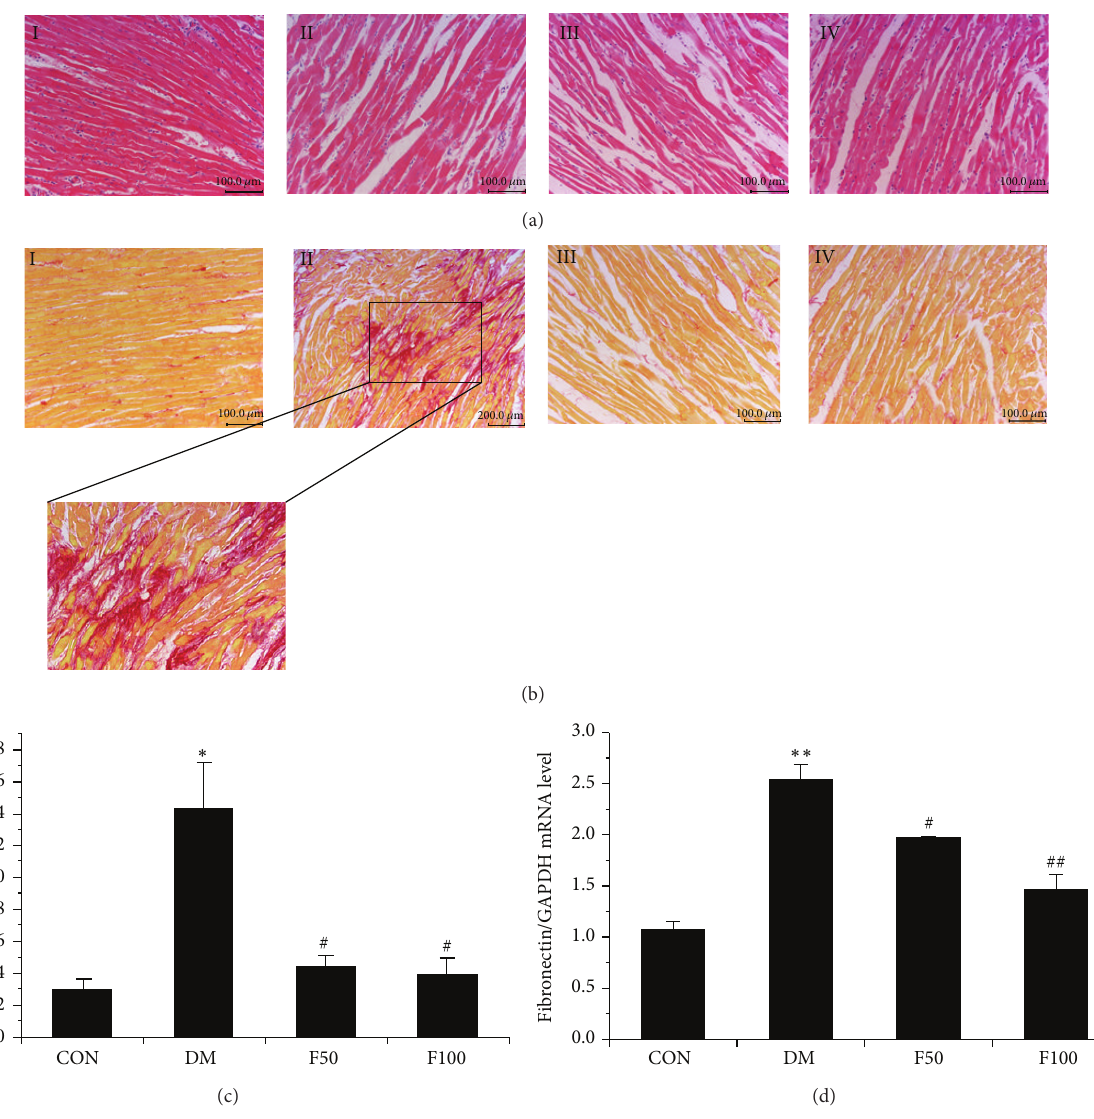
Figure 2: LMWF attenuated pathological changes in the hearts of diabetic GK rats. Representative micrographs of myocardial tissue sections stained with Hematoxylin and Eosin (a) and Sirius Red (b) for each group ( 𝑁 = 3 , scale bar = 100 𝜇 m). I represents control group, II represents DM group, and III and IV represent diabetic rats administered with 50 and 100 mg/kg/day LMWF, respectively. The black lined-box (in (b)) shows a high-magnification micrograph of Sirius Red-stained sections. Myocardial fibrosis was stained in red. (c) Fibrosis area was measured and statistical analysis was performed in different groups. (d) The level of fibronectin mRNA expression in heart tissues of each group was determined by real-time PCR, and the statistical analysis of fibronectin mRNA normalized to the housekeeping gene GAPDH was shown ( 𝑁 = 3 ). ∗ 𝑃 < 0.05 , ∗∗ 𝑃 < 0.01 versus control group; # 𝑃 < 0.05 , ## 𝑃 < 0.01 versus DM